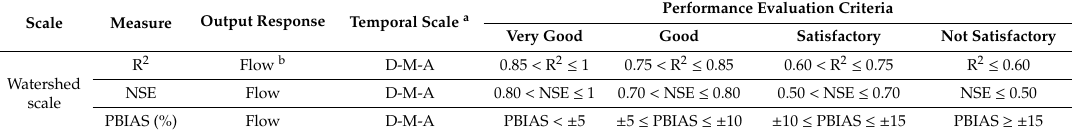
Table 4. Performance evaluation criteria for the HSPF model parameter calibration [27].